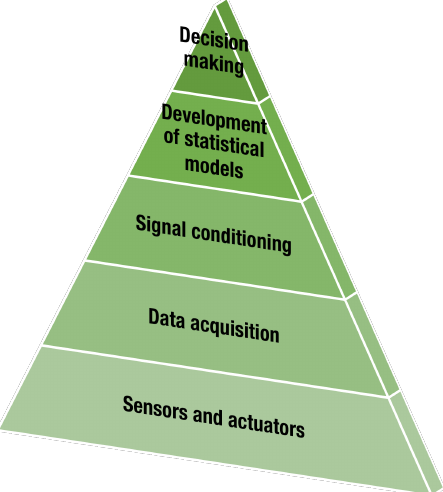
Figure 2. Development steps as a part of an structural health-monitoring (SHM)